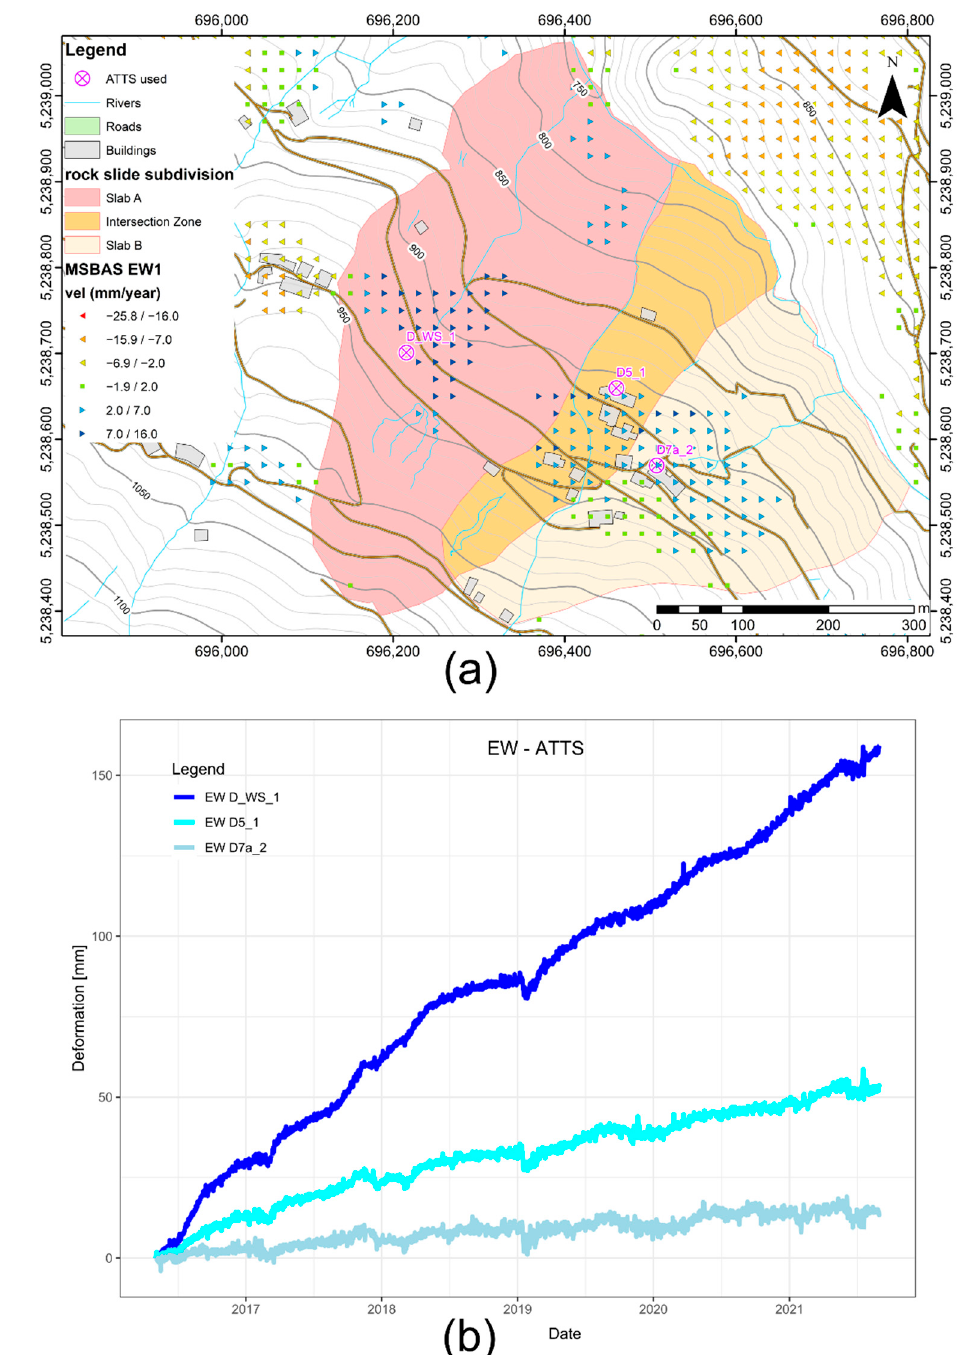
Figure 3. MSBAS velocities ( a ) and ATTS time series ( b ) for the East–West (EW) direction of motion at the Vögelsberg landslide.